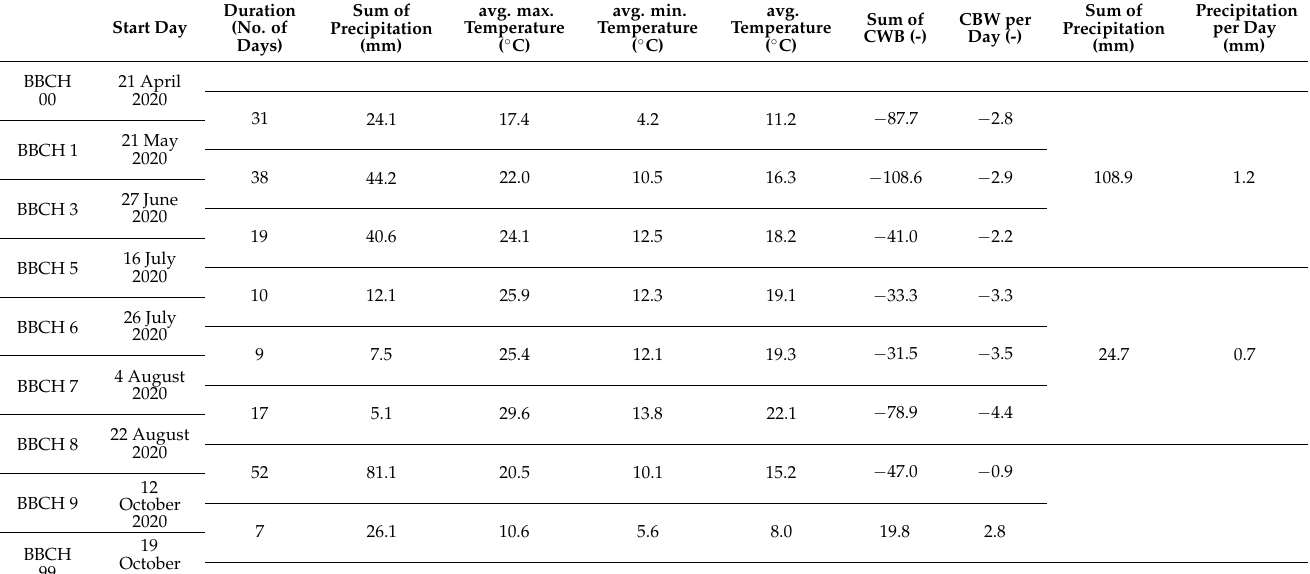
Table 4. Observed phenological development stages of maize in BBCH scale and meteorological conditions.